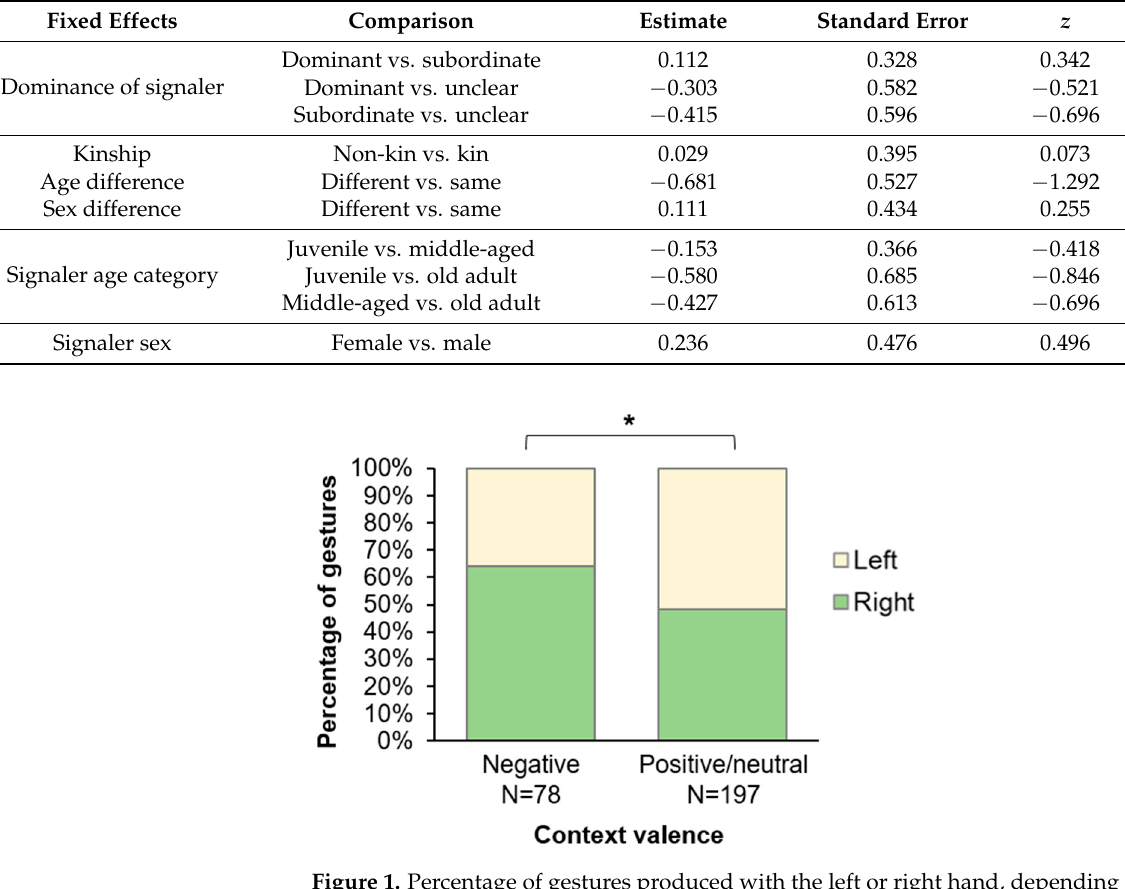
Figure 1. Percentage of gestures produced with the left or right hand, depending on the emotional valence of context. “Negative” valence corresponds to aggression and submission contexts, and “positive/neutral” corresponds to affiliation, grooming, play, and sexual contexts. GLMM Binomial: *: p < 0.05.